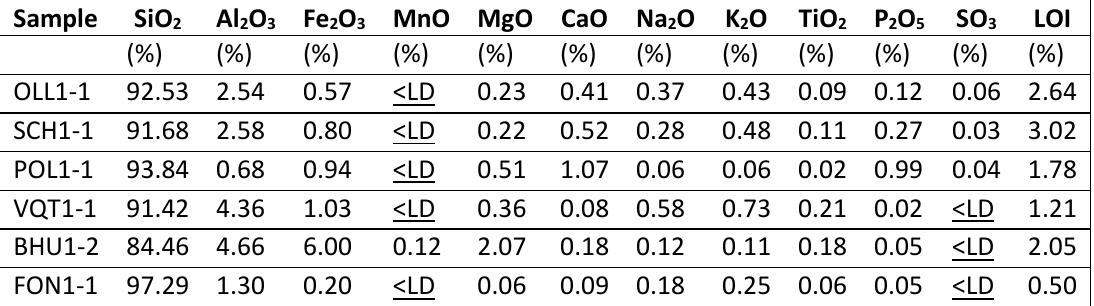
Table 4: XRF analysis of major and minor